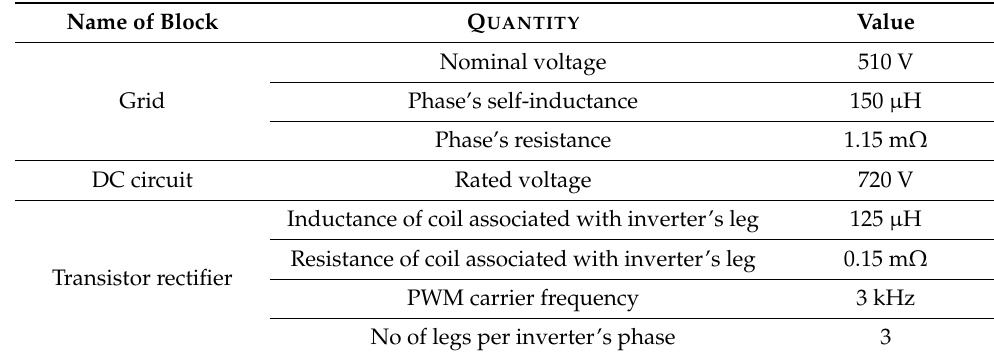
Table 2. Parameters of the transistor rectifier in 3-channel